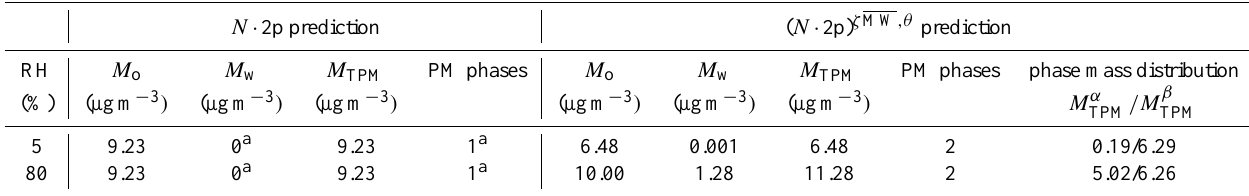
Table 7. Results for the hypothetical SOA+POA cases at 300K as predicted using the N · 2p approach and using the ( N · 2p) ζ MW ,θ approach with the CP-Wilson.1 method for prediction of ζ i values (see Table 3 for all T i values). N · 2p prediction